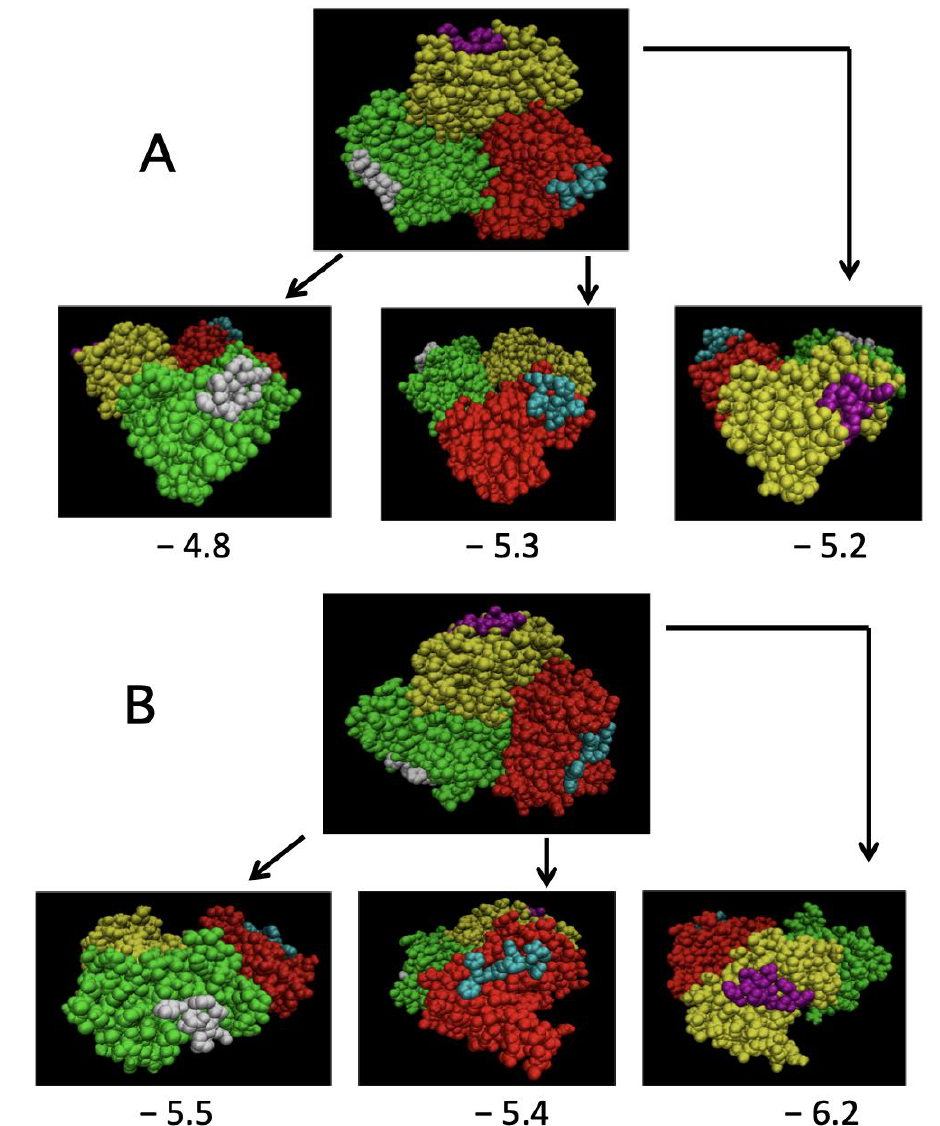
Figure 9. Results of the docking simulation of a TNF-R2 peptide to trimeric TRAF2-C at times t = 0 ns (panel ( A )) and t = 220 ns (panel ( B )). In each case, a top view (single frame) and the side view for each subunit are reported. The number shown under each picture represents the binding energy expressed in kcal/mol.